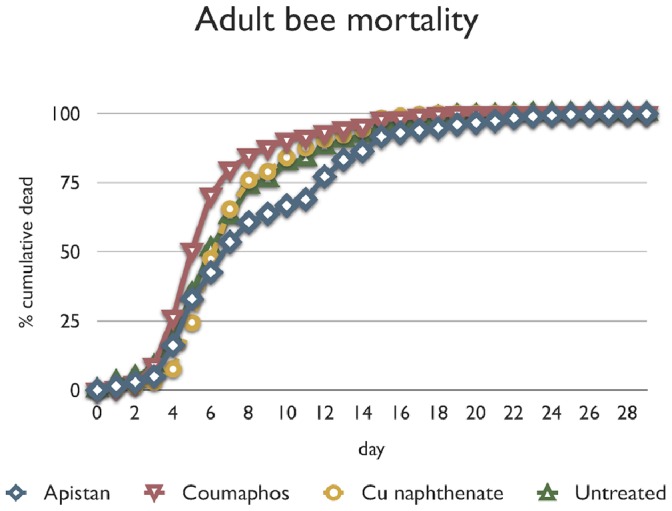
Cumulative daily adult bee mortality.Same-aged cohorts were made in the lab from adult bees reared as brood in field colonies receiving labeled rates of bee hive chemicals. The cohorts were followed for cumulative daily mortality. The figure shows plotted raw data, not the proportional hazard curves fitted in the model.